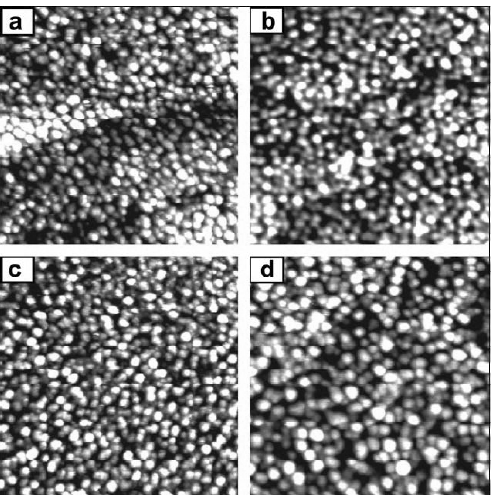
Fig. 13 – STM images (size 60 × 60 nm 2 , V S = 3 V, I = 0 . 1 nA) of 0.5Å niobia/aluminasamples: (a)aspreparedat300K;(b)-(d)flashed to 500, 700 and 900 K, respectively. Antiphase domain boundaries are clearly seen in (d) due to migration of the niobia deposits through the line defects and their decoration (Uhl et al. 2007).